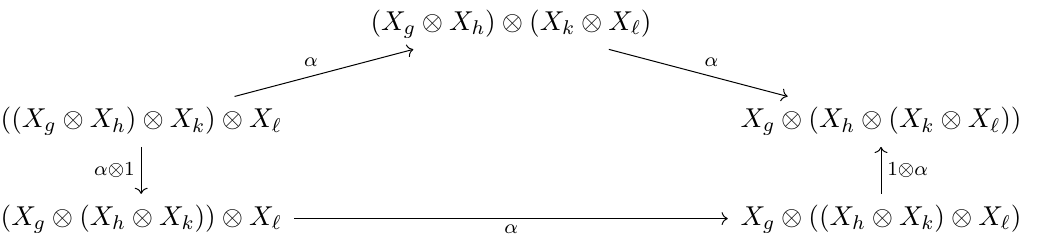
Figure 5 . Given 4 defect lines X g , X h , X k , and X ‘ , we only demand that the pentagon diagram commutes. This is familiar to those in RCFT as the pentagon identity for